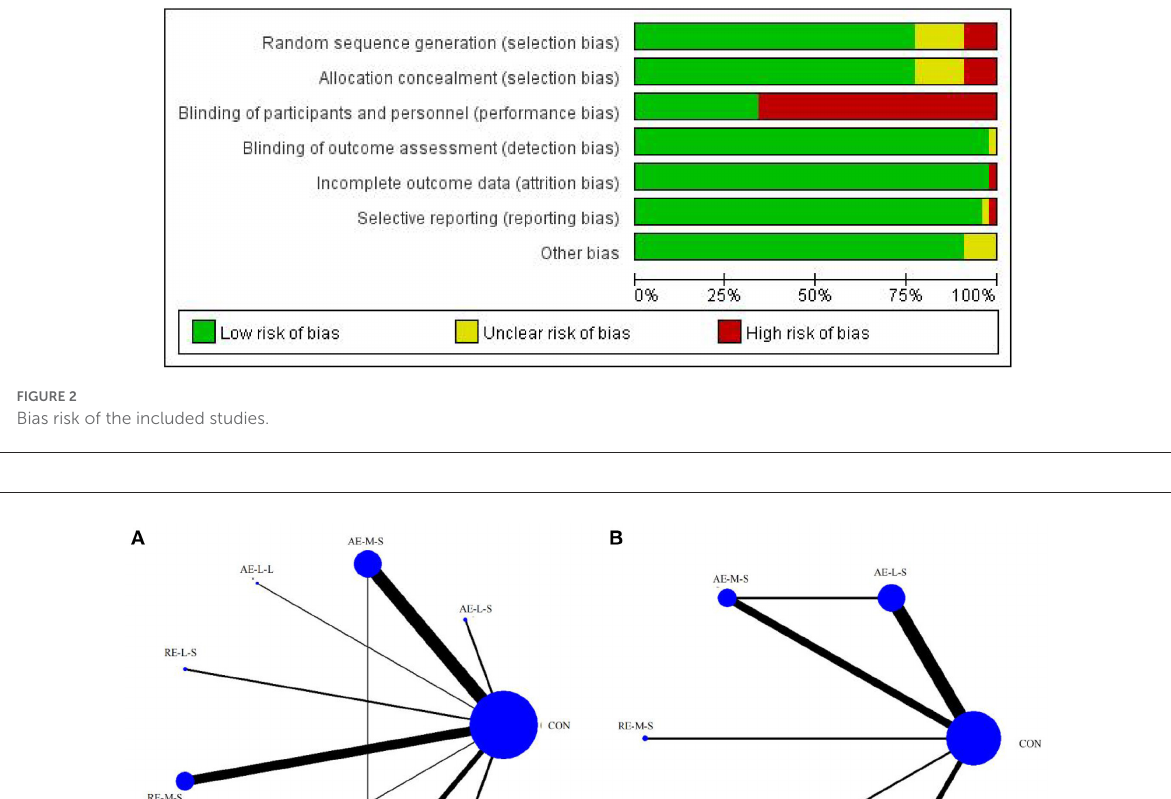
the number of participants for that intervention type and the thickness of the line between interventions relates to the number of studies for that comparison. Tables 3–5 detail the full outcome